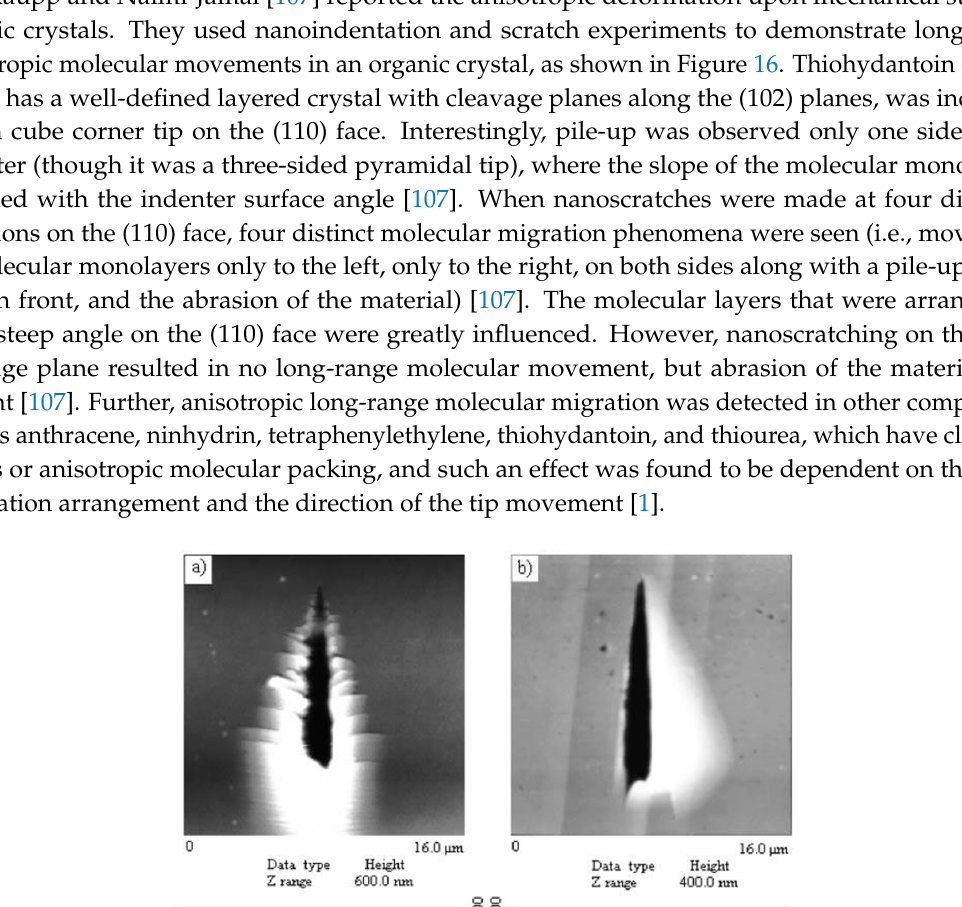
Figure 16. Atomic force microscope images of residual scratches on the (110) face of thiohydantoin crystal. ( a ) Along the skewed layers direction showing pile-up only on both sides, ( b ) scratch along the cleavage plane resulting in pile-up only on the right side, ( c ) horizontal cross-section profile at the broadest width in ( a ), ( d ) horizontal cross-section profile at the broadest width in ( b ), ( e ) scratch against the sloping of the skew layers showing no-pile up, and ( f ) scratch along the cleavage planes resulting in pile-up only on the left side. (Reproduced with permission from the Wiley, Reference 107). Varughese et al. [108] studied the layer migration in pyrene and phenanthrene based on two charge transfer complexes of 1,2,4,5-tetracyanobenzene (TCNB) using nanoscratching experiments. A 75-nm sharp three-sided pyramidal Berkovich tip was used to scratch the major (100) and (002) faces of 1:1 TCNB–pyrene crystals, which have a layered arrangement (shown in Figure 17). While the layers mean that the plane is parallel to the (100), they make an angle of 68° tilt to (002). The large difference in the interaction characteristics and layer arrangement of both the faces resulted in